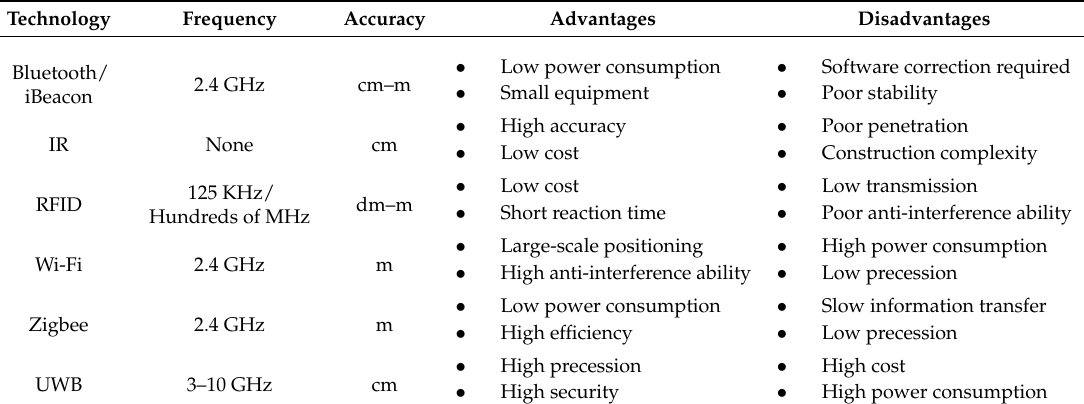
Table 1. Comparison of Wireless Indoor